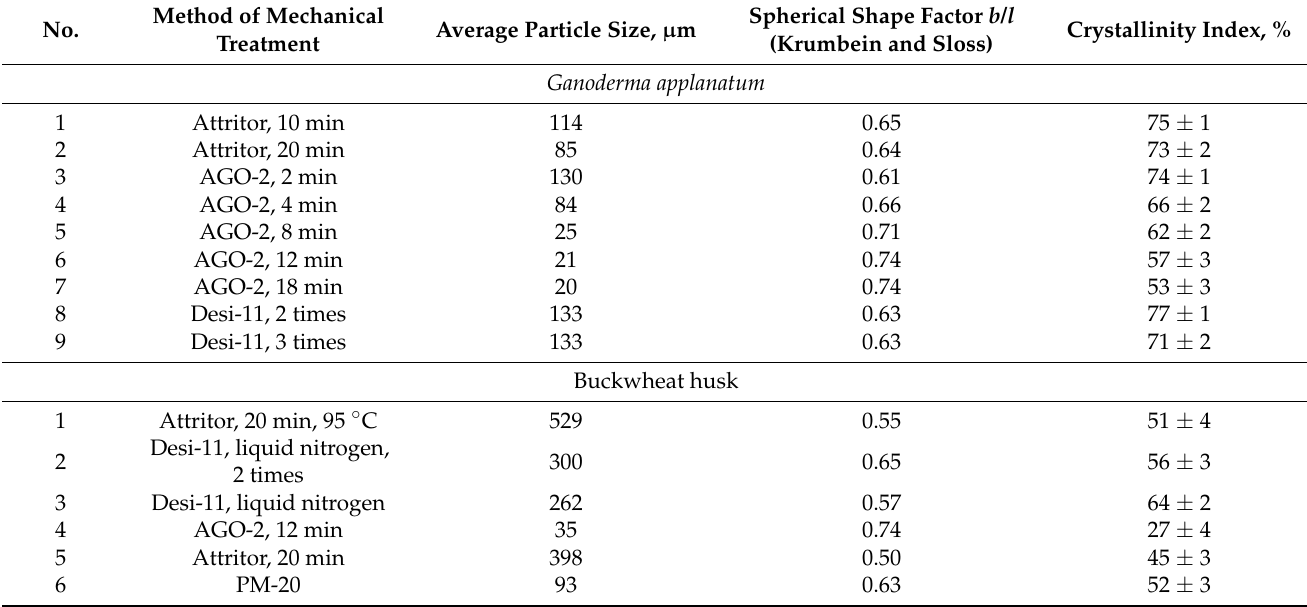
Table 1. Size and shape characteristics of particles of the analyzed raw